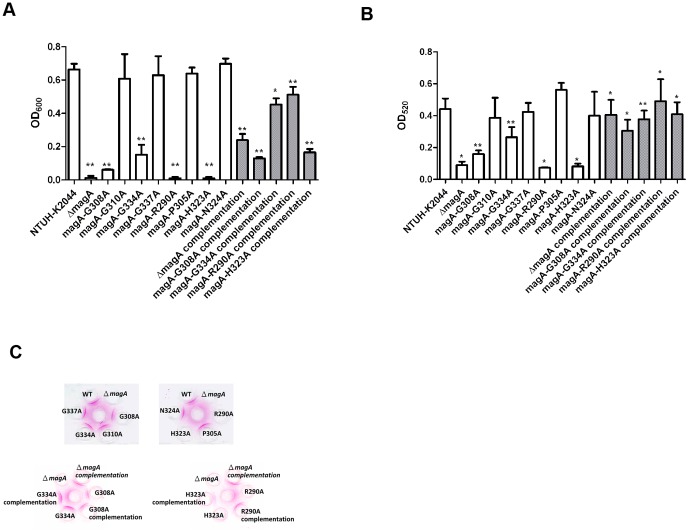
Mucoviscosity and CPS of magA point mutants.
A. Mucoviscosity of K. pneumoniae NTUH-K2044 wild type, ΔmagA mutant, magA (G308A, G310A, G334A, G337A, R290A, P305A, H323A and N324A) site-directed mutant strains and complementation strains. The mucoviscosity determined by centrifugation was represented by OD600 of three independent experiments (mean±SD). (wild type vs. ΔmagA, P<0.0001; wild type vs. magA-G308A, P = 0.0012; wild type vs. magA-G334A, P = 0.0097; wild type vs. magA-R290A, P = 0.0012; wild type vs. magA-H323A, P = 0.0012; ΔmagA vs. ΔmagA complementation, P = 0.0070; magA-G308A vs. magA-G308A complementation, P = 0.0034; magA-G334A vs. magA-G334A complementation, P = 0.0181; magA-R290A vs. magA-R290A complementation, P = 0.0029; magA-H323A vs. magA-H323A complementation, P = 0.0031; Student's t test) **P<0.01 *P<0.05. B. CPS production of K. pneumoniae NTUH-K2044 wild type, ΔmagA mutant, magA (G308A, G310A, G334A, G337A, R290A, P305A, H323A and N324A) site-directed mutant strains and complementation strains. The amount of CPS was represented by OD520 of three independent experiments (mean±SD). (wild type vs. ΔmagA, P = 0.02; wild type vs. magA-G308A, P = 0.0098; wild type vs. magA-G334A, P = 0.0048; wild type vs. magA-R290A, P = 0.0109; wild type vs. magA-H323A, P = 0.0173; ΔmagA vs. ΔmagA complementation, P = 0.0392; magA-G308A vs. magA-G308A complementation, P = 0.0332; magA-G334A vs. magA-G334A complementation, P = 0.0040; magA-R290A vs. magA-R290A complementation, P = 0.0349; magA-H323A vs. magA-H323A complementation, P = 0.0239; Student's t test) **P<0.01 *P<0.05. C. Double immunodiffusion assays of rabbit anti-K. pneumoniae K1 serum with capsular extracts of different K. pneumoniae strains. The rabbit anti-K1 serum from Statens Serum Institute is in the center well and capsular extracts of overnight-cultured K. pneumoniae strains are in peripheral wells. The names of the strains are labeled in the peripheral wells. A red precipitation line near the peripheral well is considered as a positive reaction.